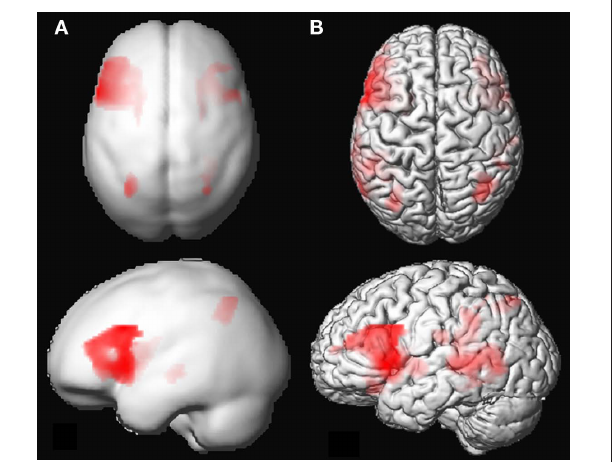
FIguRe 2 | (A) 3D rendering of language activation from the group analysis, intensity projected onto the gray-matter MNI space template from SPM5. FDR corrected (threshold 0.05) for the whole brain, voxel extent = 20. For labeling of activated areas, see Table 2. (B) Activation map of 1 representative individual subject, intensity projected on normalized gray-matter rendering of the subject’s T1 scan. LI-fMRI = 0.75, LI-fTCD ( Table 2 ). The first cluster showed activity in the left pre-central gyrus, the left putamen, and the triangular part of the left inferior frontal gyrus. The second cluster showed activity in the right puta- men. The third cluster showed activity in the left inferior parietal